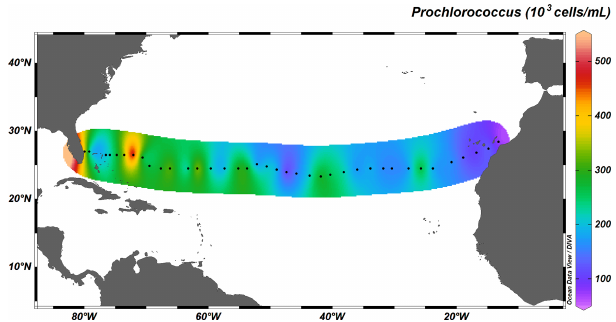
Figure 8. Depth-integrated abundance of Prochlorococcus (in 10 3 cellsmL − 1 ) above MLD. Black dots represent the 38 out of the total 135 stations sampled for cyanobacterial